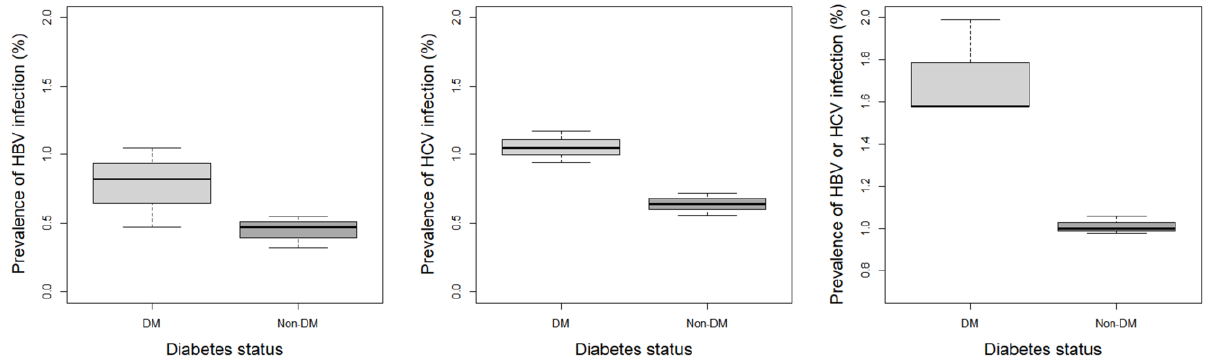
Figure 2. Prevalence of each hepatitis regarding the diabetes mellitus status. DM, diabetes mellitus; HBV, hepatitis B virus; HCV, hepatitis C virus.